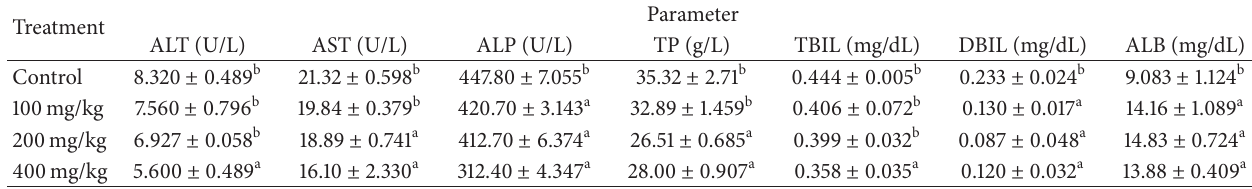
Table 2: Clinico-chemical parameters of liver function of healthy chickens exposed to combined aqueous extract of Azadirachta indica and Khaya senegalensis .